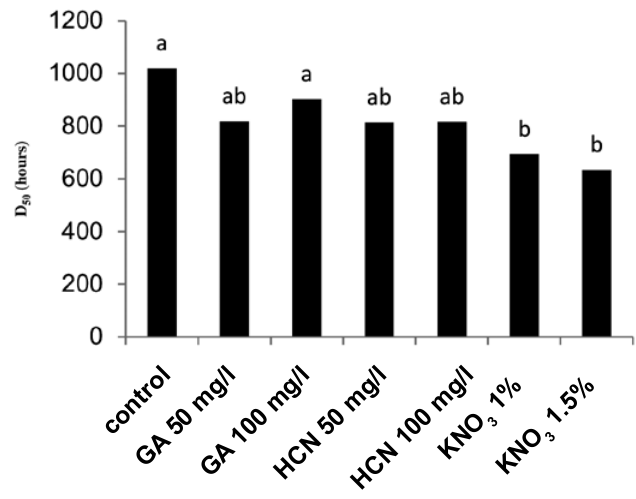
Fig. 3 - Effect of different priming agents on time to reach 50% germi- nation (G ) of Abbasali pistachio 50%